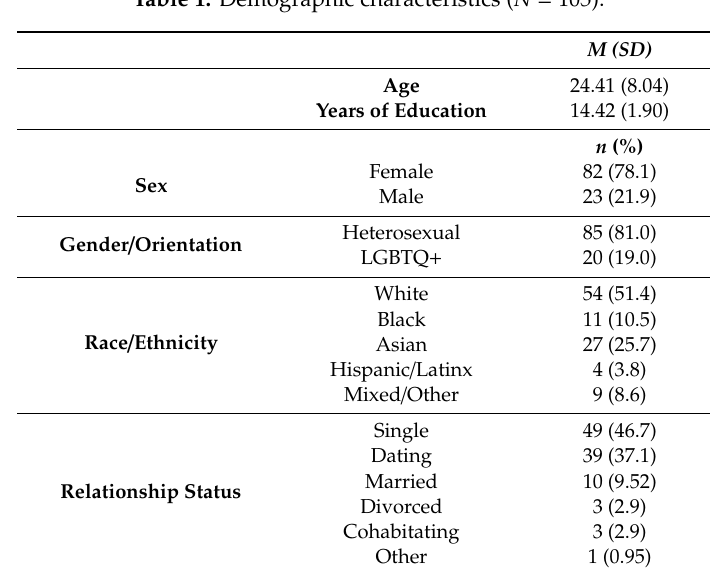
Table 1. Demographic characteristics ( N =